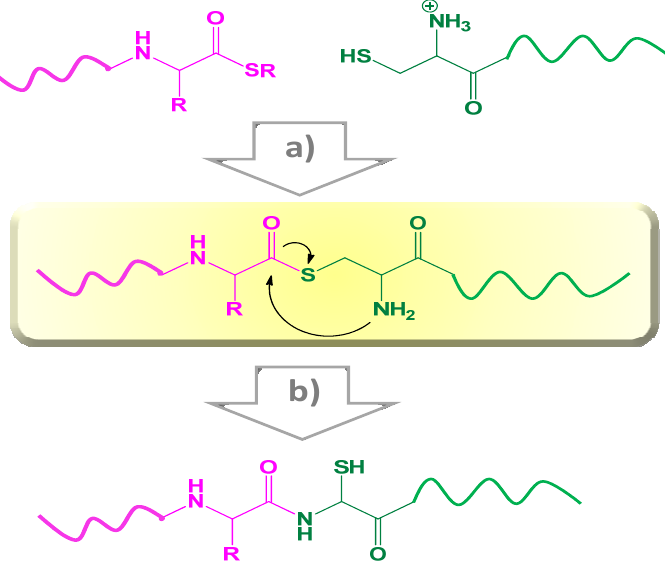
Figure 4. Native chemical ligation. ( a ) water, pH = 7; ( b ) rearrangement of thioester intermediate amide linked